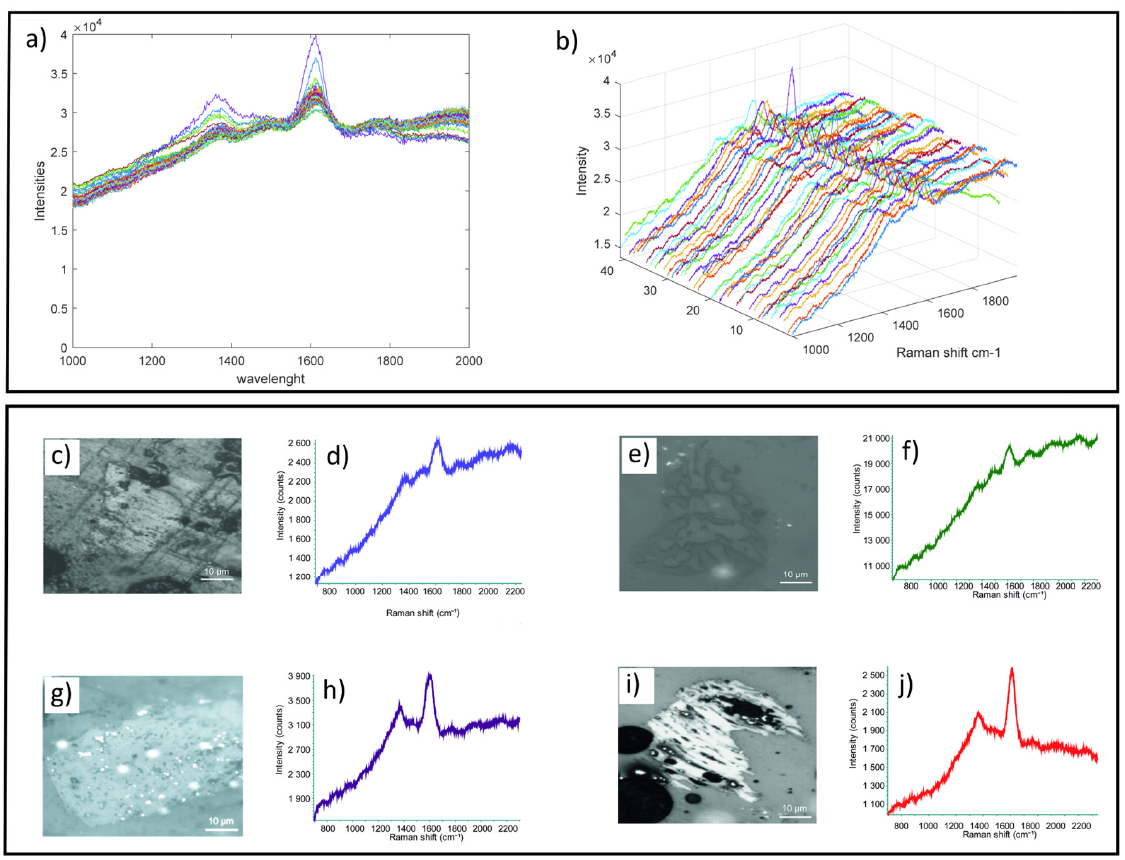
Figure 5. Example of normalized spectra in 2D ( a ) and 3D ( b ) view acquired on sample PL 93.1. Raman spectra of different macerals analysed (each Raman spectrum was measured on a 2 micron spot located at the center of the image): ( c ) microphotograph of a maceral recognized as belonging to the vitrinite group and ( d ) its related spectrum; ( e ) possible liptinite macerals with ( f ) a high fluorescence spectrum; ( g ) microphotograph of a maceral recognized as semifusinite and ( h ) its related spectrum; ( i ) microphotograph of a maceral recognized as belonging to the inertinite group and ( j ) its related spectrum. Note that lighting is not the same for each photo.